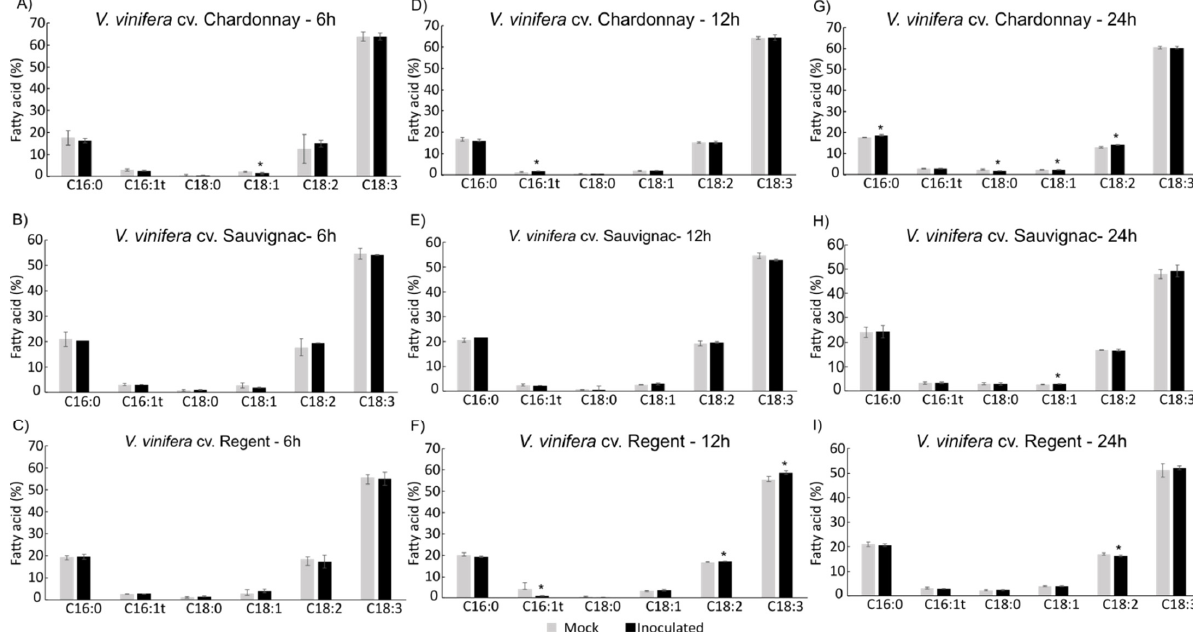
Figure 6. Fatty acid composition of mock-inoculated and inoculated leaves of V. vinifera cultivars. Chardonnay, Sauvignac and Regent with P. viticola (NW-10/16 isolate), at 6, 12 and 24 hpi. Values correspond to average ± standard deviation, * significantly different p < 0.05 , n =